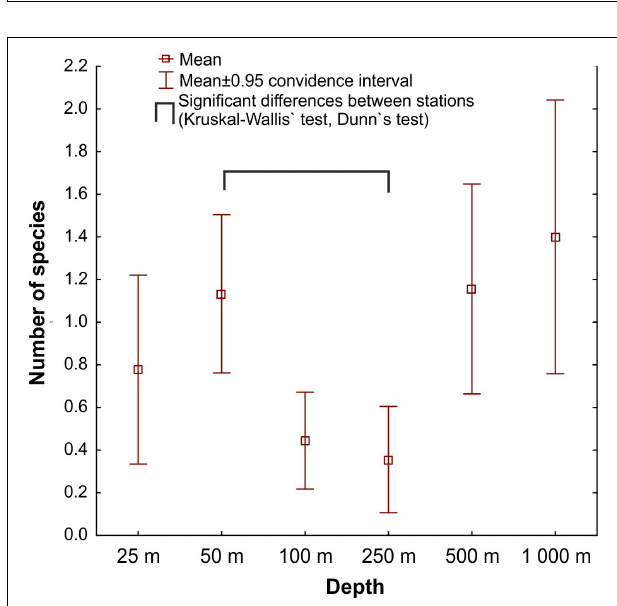
FIGURE 4 | Mean species richness per sample (S) at each sampled